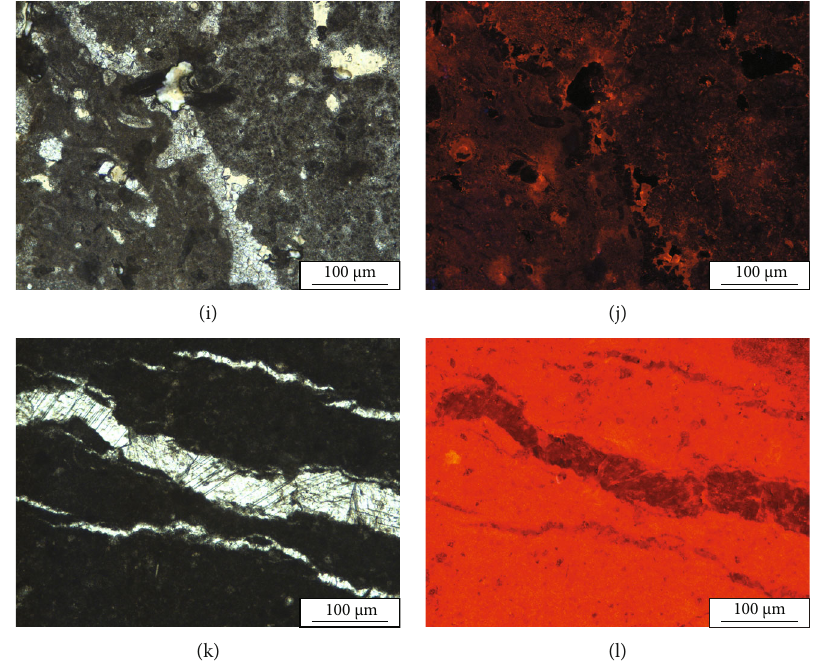
Figure 3: Cathodoluminescence characteristics of the J